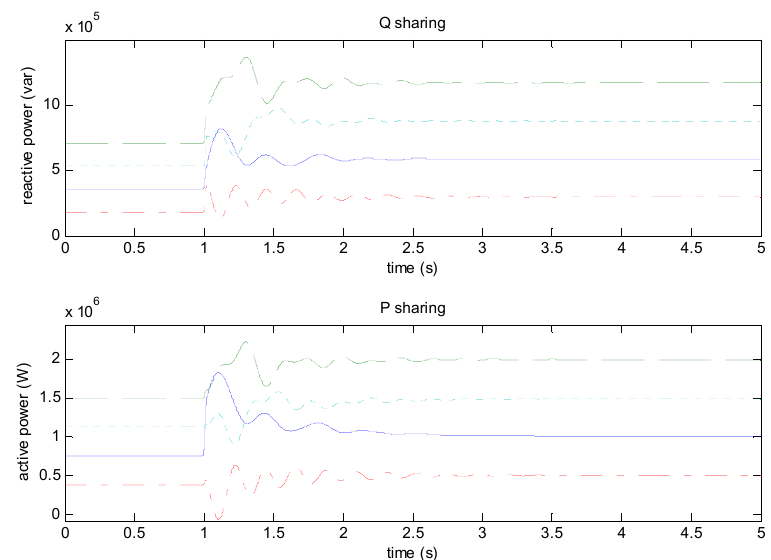
Figure 13. PCC voltage and frequency in Scenario I.